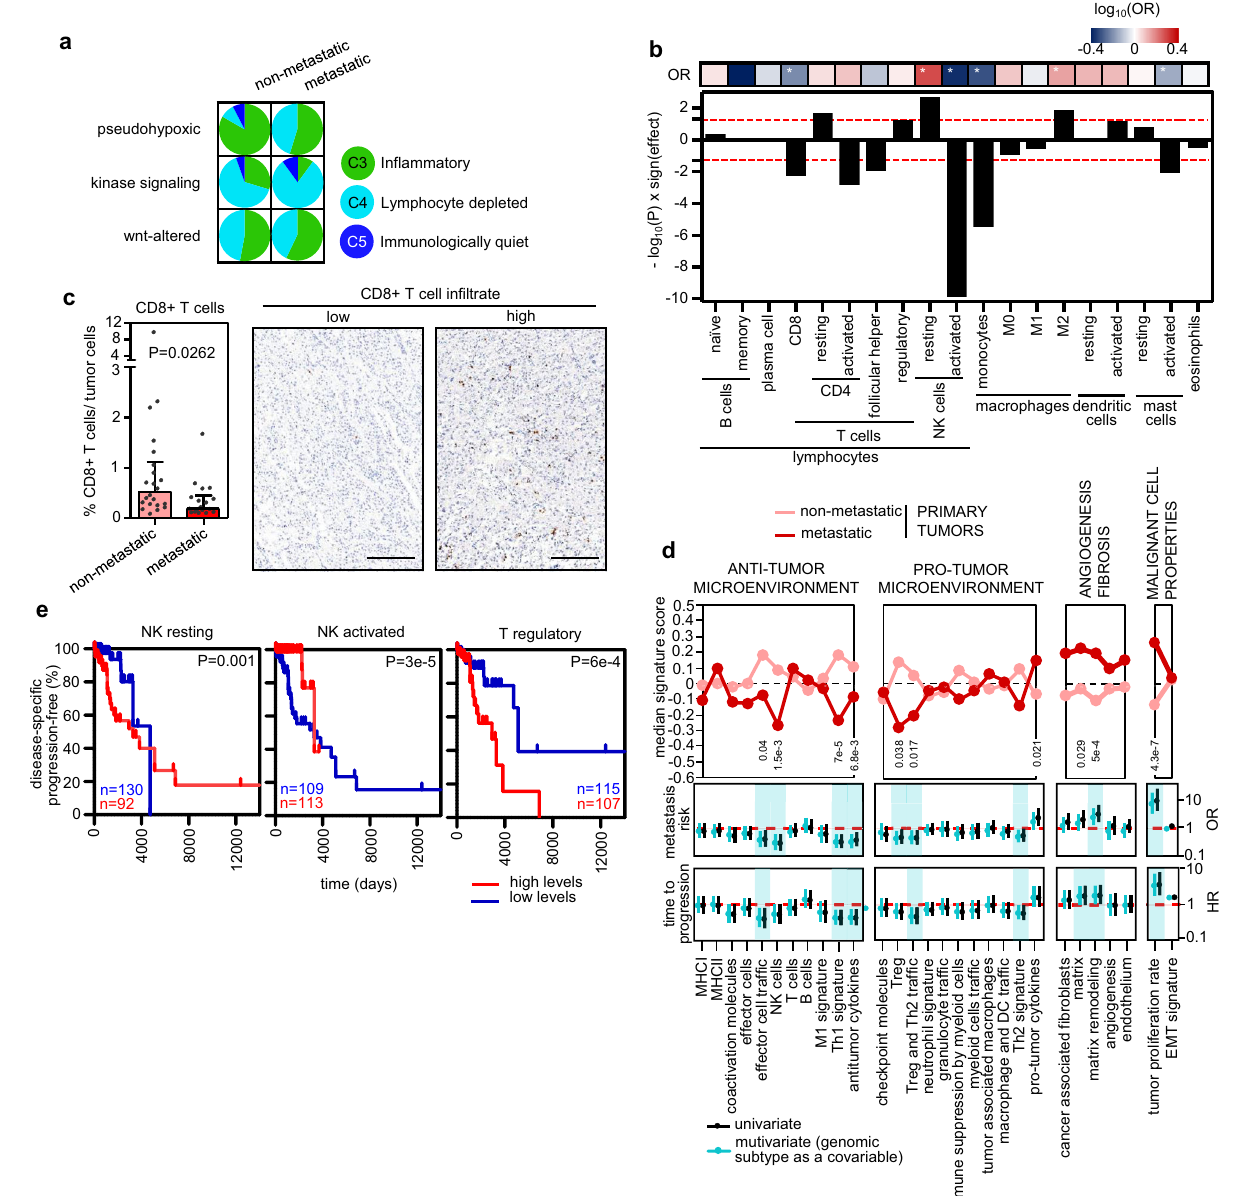
Fig. 6 | Immune landscape in PPGLs. a Classi fi cation of immune subtypes within tumor tissue types and genomic subtype. The proportion (%) of samples of each immunesubtypepertumortypeandgenomicsubtypeisshown.Aggressivetumors were excluded from pie charts due to the low number of samples available. b Plot showing the − log 10 (P) resulting from a two-sided MWW analysis to de fi ne differ- ences between metastatic primary versus non-metastatic tumors in the different immune cell classes estimated with CIBERSORTx. The ‘ sign(effect) ’ indicates the direction of the fold-change between the proportions in both groups. Cell types with >85% of the samples with ‘ 0s ’ were excluded from the analysis. Columns that surpass the red dashed line have P <0.05. The top row summarizes univariate logistic regression analysis comparing immune cell proportions and metastatic risk. The color of the cell is relative to the − log 10 (OR), and * indicates P <0.05. c Percentage of CD8+ T cells in fi ltrated among tumor cells detected by immuno- histochemistry (left) in a subset of n =39 PPGLs with different clinical behavior. Three PPGLsclassi fi edas aggressive were notincluded in this analysis, and fortwo cases IHC were not assessable. Median ± IQR is shown. Two-sided MWW was applied to test fordifferences. Representative images (right) ofCD8 IHC. Scalebar inimages=200 μ m. d Top panel:medianenrichmentscoreofthedifferentFgesin